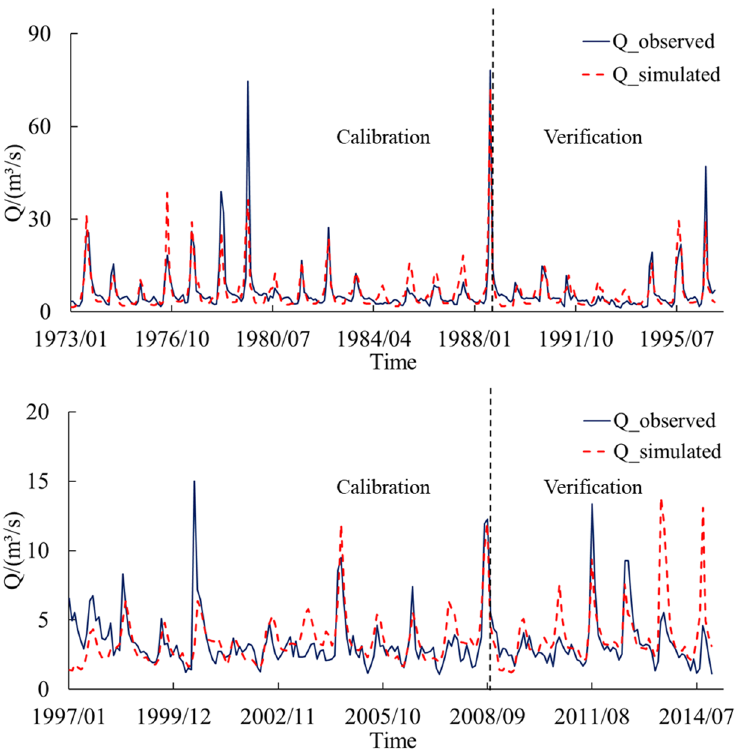
Figure 6. Monthly observed and simulated discharge (m 3 /s) before and after 1996 in the upper Tang River catchment.